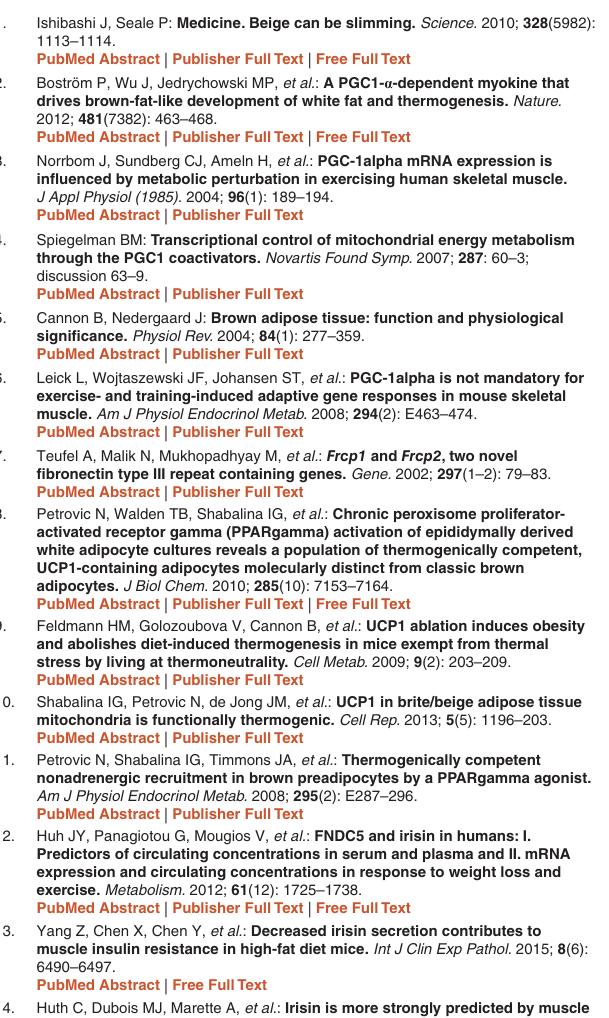
Supplementary Table 1: PRISMA checklist. Click here to access the data. Supplementary Figure 1: PRISMA flow diagram of study selection and identification. Click here to access the data. Supplementary Figure 2: Summary of risk of bias assessment using the Cochrane Collaboration’s tool. Click here to access the